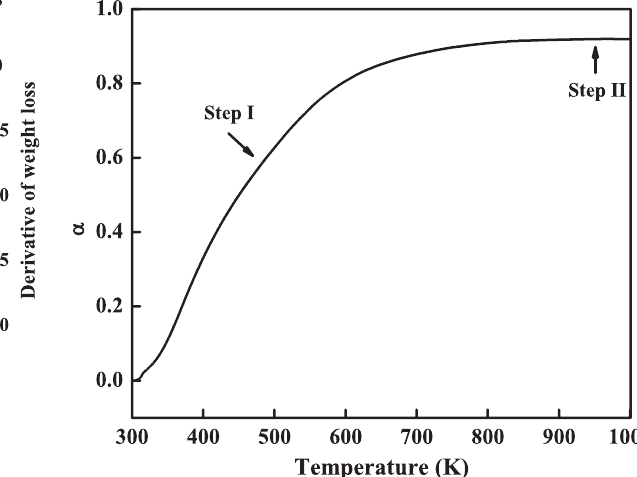
Fig. 6: Change in decomposition fraction ( α ) with respect to temperature (T) for the particles shown in Fig.